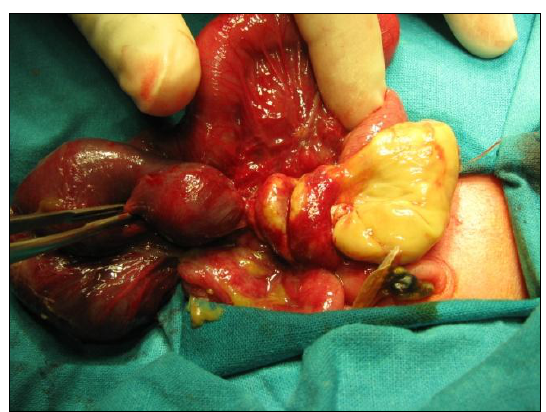
Figure 2: PSV in the second